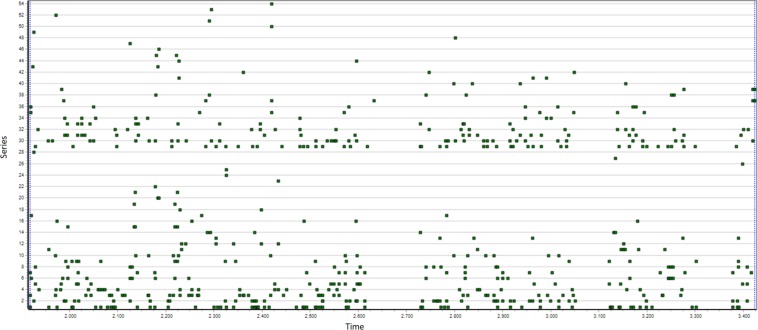
This figure shows T-data of one problem solving dyad, where the two children (e and n) attempt to solve together a puzzle with three consecutive stages.